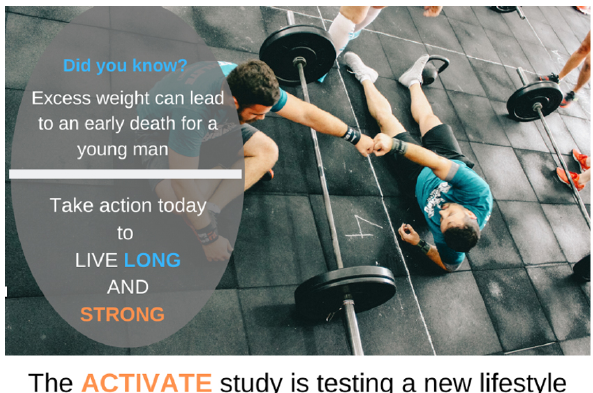
Fig. 1. Example of male-target recruitment advertisement based in extended parallel process